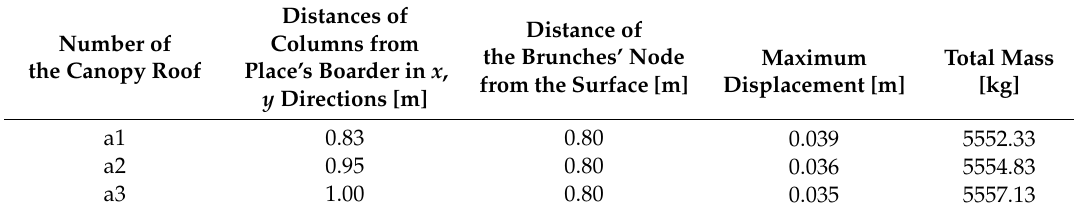
Table 2. The results of the simulation assuming bar lengths within the scope of 1.5 m–2.0 m.